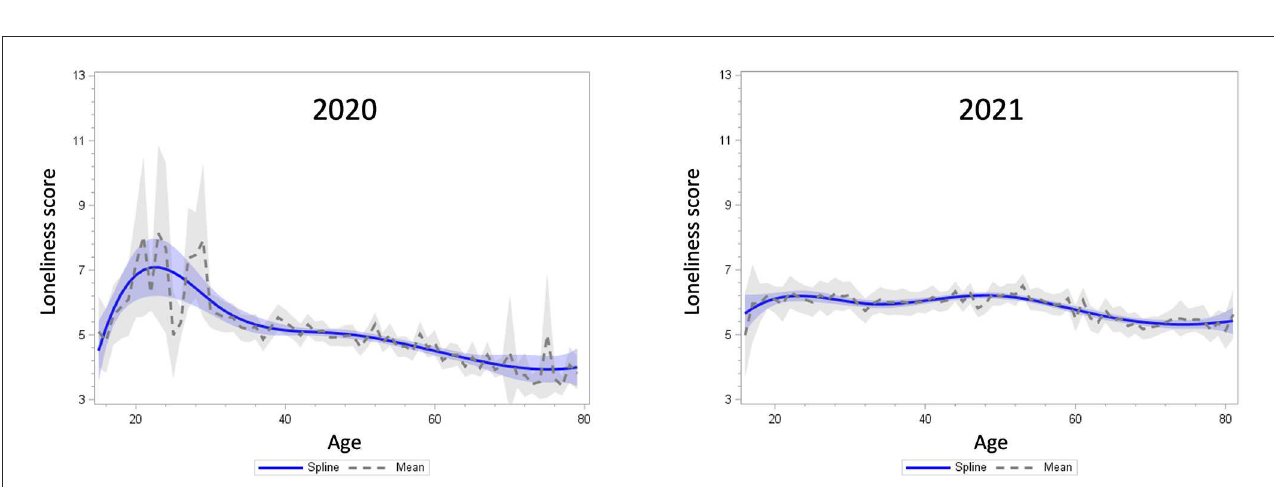
FIGURE2 Distribution of the UCLA loneliness scale scores by age in 2020 (left) and 2021 (right) . The confidence bands reflects the 95% confidence intervals of the